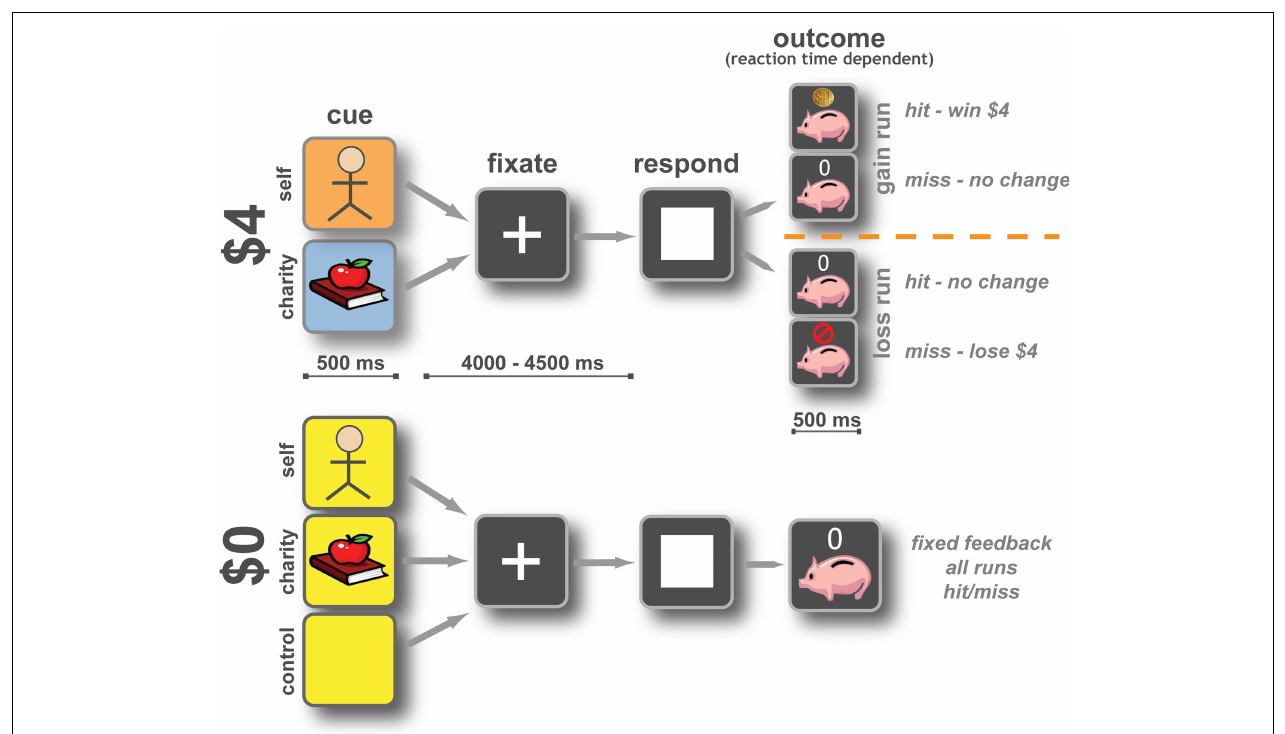
FIGURE 1 | Participants performed a monetary incentive reaction time task. An initial cue marked the start of the trial and indicated whether money was at stake and, if so, who would receive it. Each trial offered either $4 or $0, for the participant (Self), a charity (Charity), or no one. Gain and loss outcomes occurred in separate runs, to minimize cue confl ict. After a variable wait (4–4.5 s) a response target appeared indicating that participants were to press a button using their right index fi nger as quickly as possible. The trial was scored as a hit if the participant responded in time or as a miss if they did not. Changes to the bank as a result of that trial were then displayed for 0.5 s. In gain runs on $4